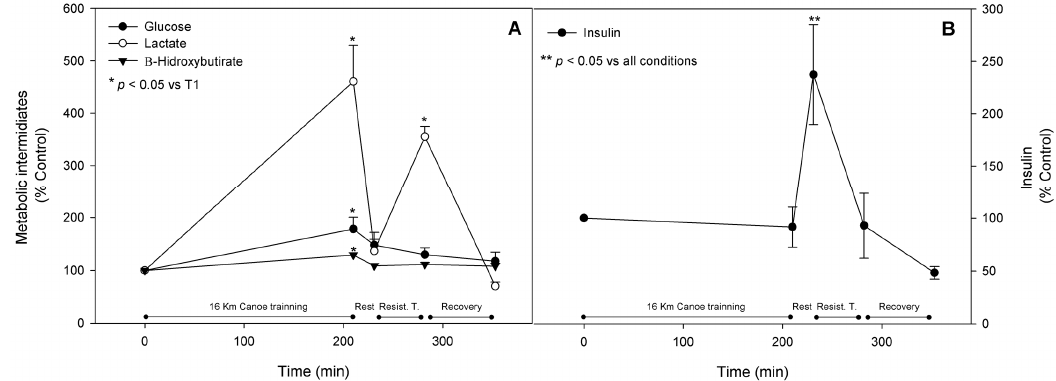
Figure 9. Metabolic intermediates and Insulin. Glucose, lactate, 2-hidroxybutirate (A), and insulin (B) were assessed as described in materials and methods and are represented as mean ± standard error of percentage values against control. * Indicates statistical difference against control values ( p < 0.05). ** Indicates statistical significance when compared to all conditions ( p < 0.05).